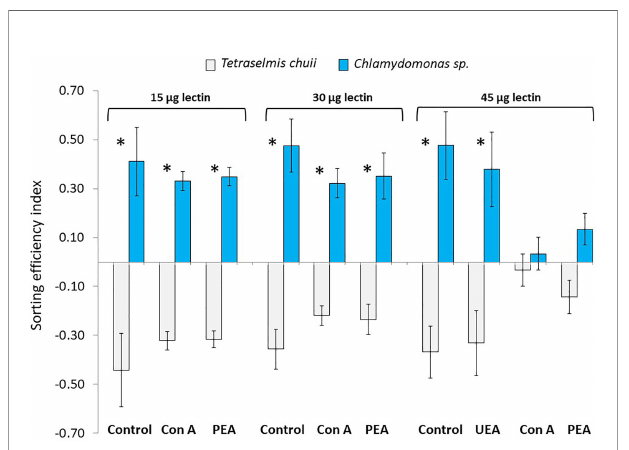
FIGURE 4 | Sorting ef fi ciencies (mean ± standard deviation, n = 12 per data point) of M. edulis fed a mixture of BSA- and neoglycoprotein-coated microspheres (glucose-BSA or fucose-BSA; from 0.05 to 1.24 10 9 molecules of carbohydrates per microsphere). *Indicates signi fi cant